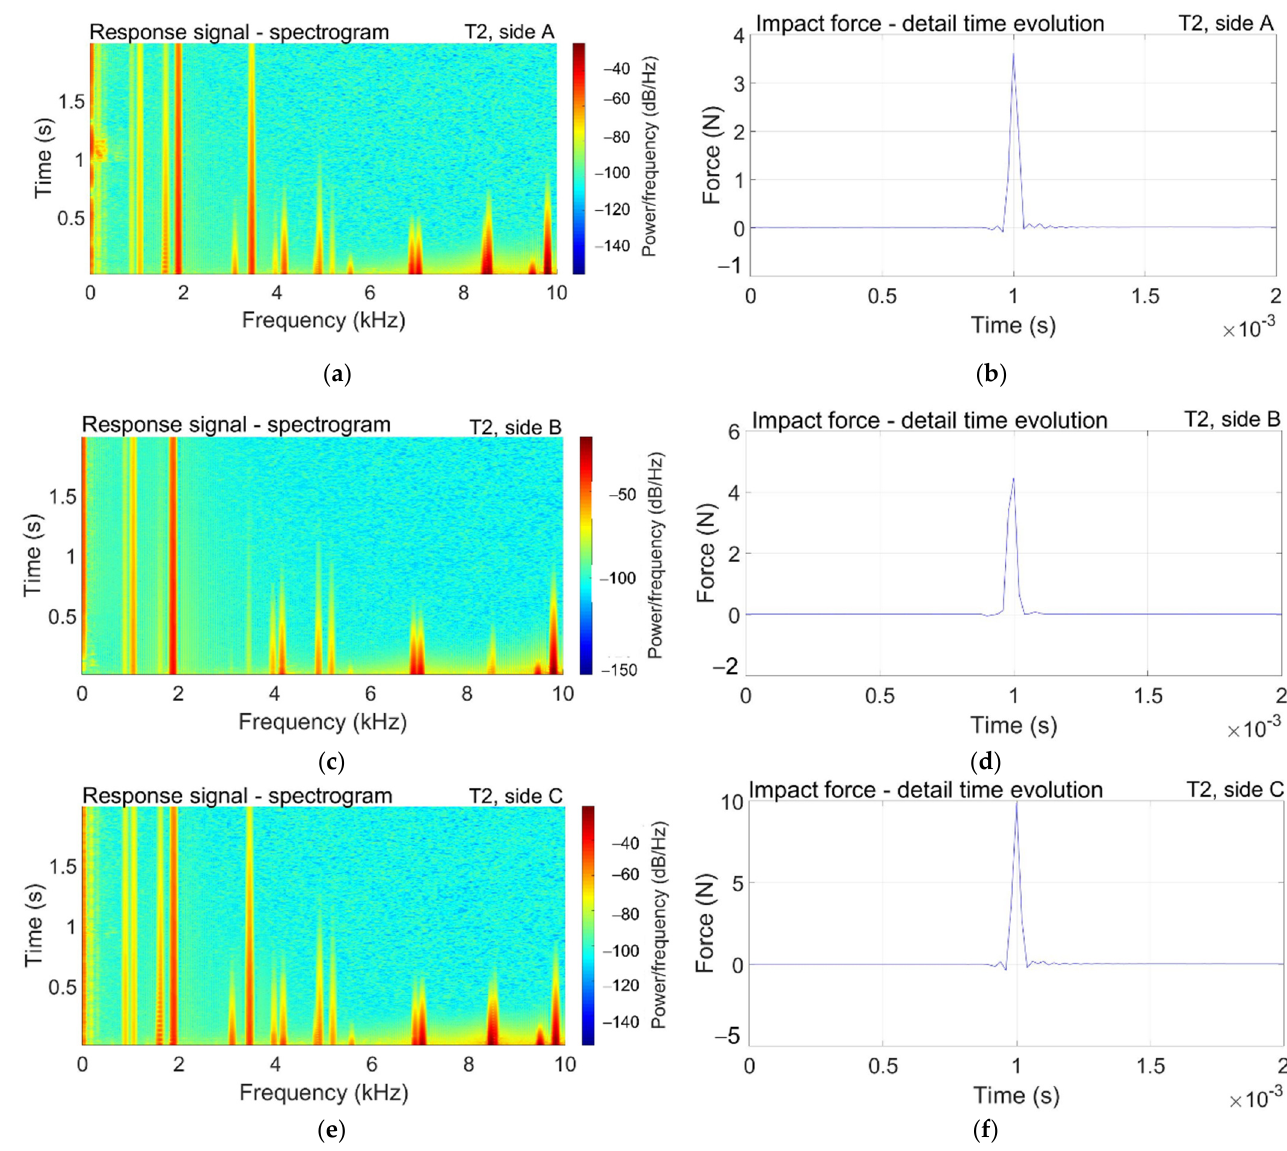
Figure 7. The spectrograms and the graphs of impact force, for aluminum triangle T2: ( a ) in case of excitation of side A; ( b ) the plot of excitation force against the time, by hitting side A; ( c ) in case of excitation of side B; ( d ) the plot of excitation force against the time, by hitting side B; ( e ) in case of excitation of side C; ( f ) the plot of excitation force against the time, by hitting side C.